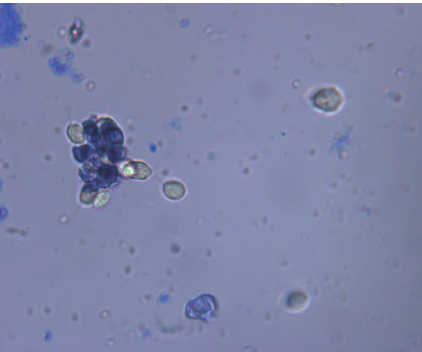
Figure 7: Microscopic image of the trichomonacidal activity of dye I against T. vaginalis trophozoites after 48 hours.